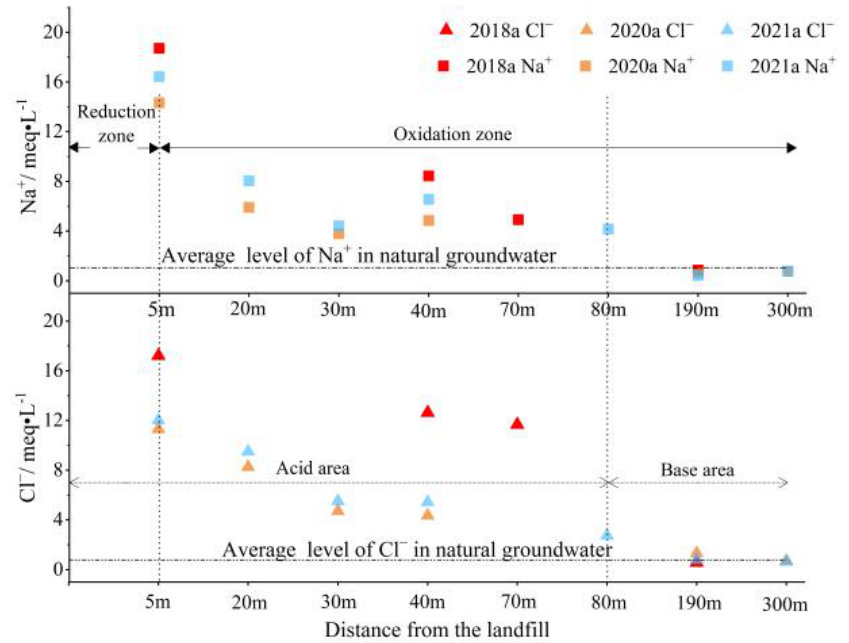
Figure 6. Milliequivalent concentration of Na + and Cl − in groundwater downstream of the landfill.